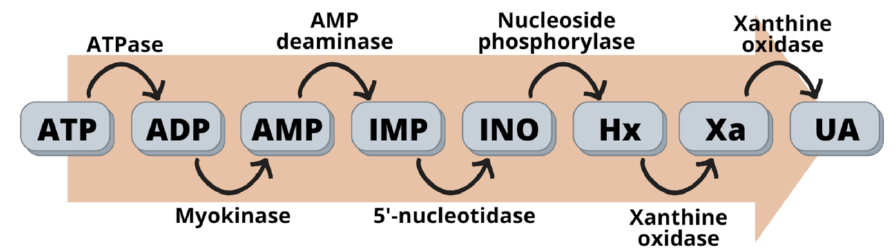
Figure 2. The catabolism of ATP with the respective enzymes responsible for the oxidation of each